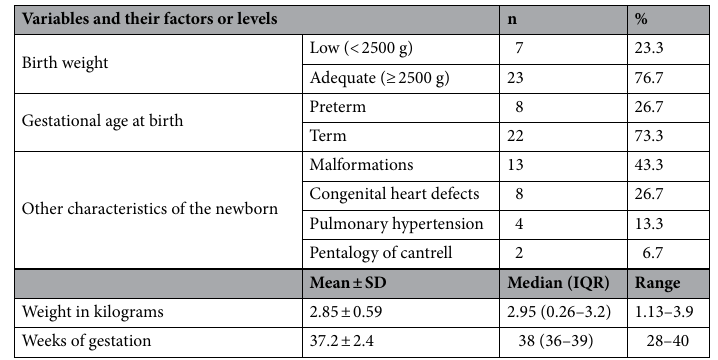
Table 1. Clinical characteristics of the study subjects. SD standard deviation, IQR interquartile range.